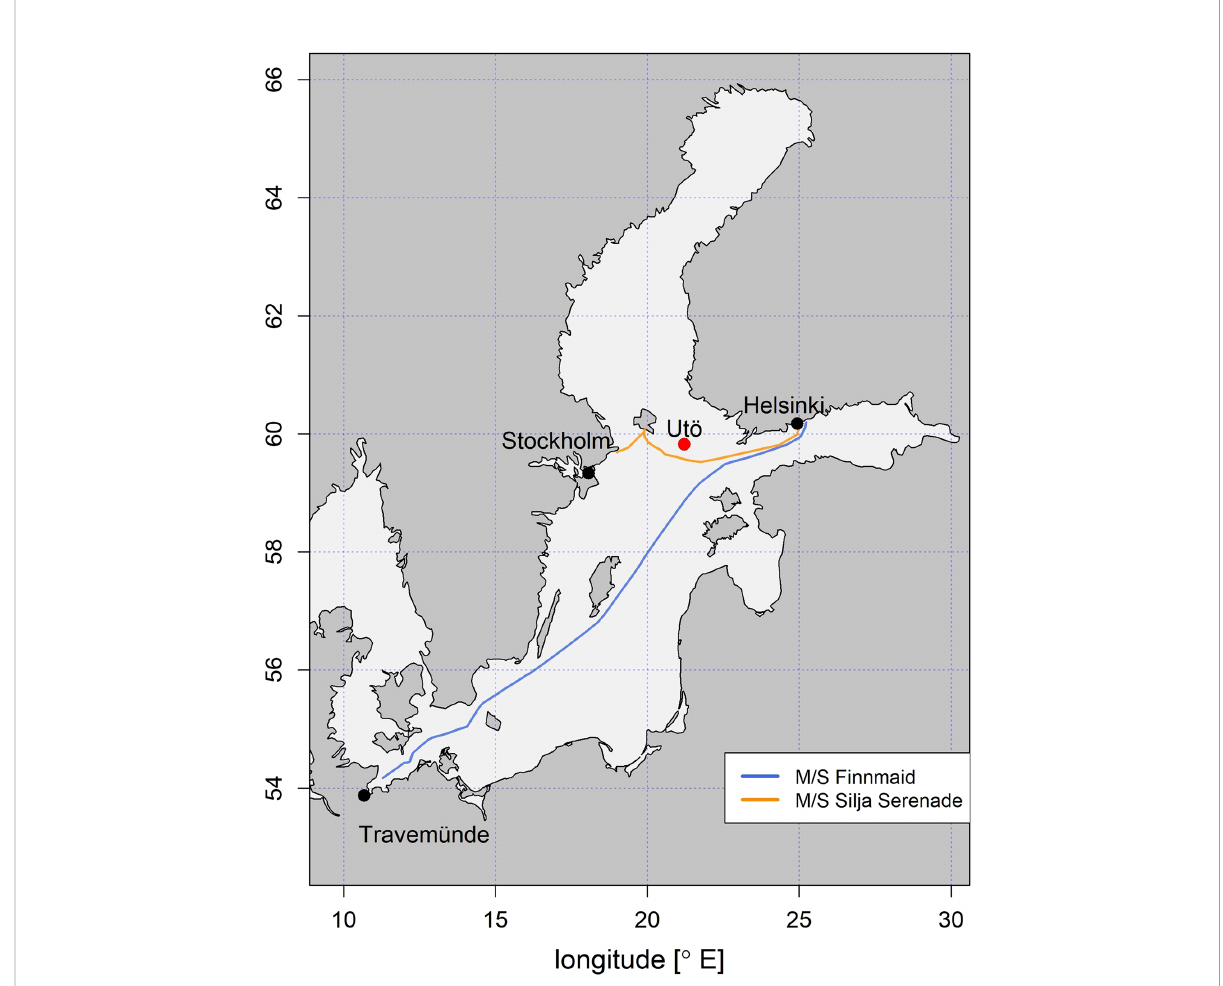
FIGURE 2 Map showing the location of Utö Atmospheric and Marine Research Station, and the points along the Alg@line routes of M/S Finnmaid and M/S Silja Serenade, from where the manually annotated samples were